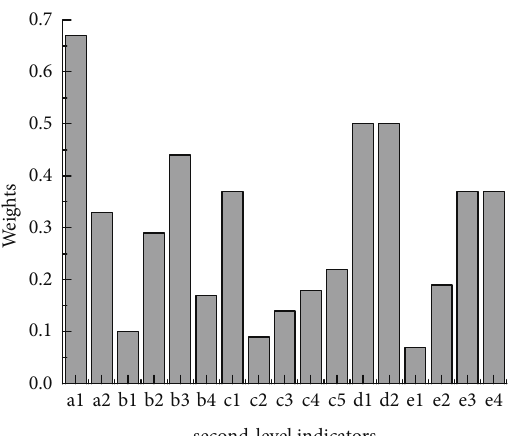
Figure 9: Weight value of second-level